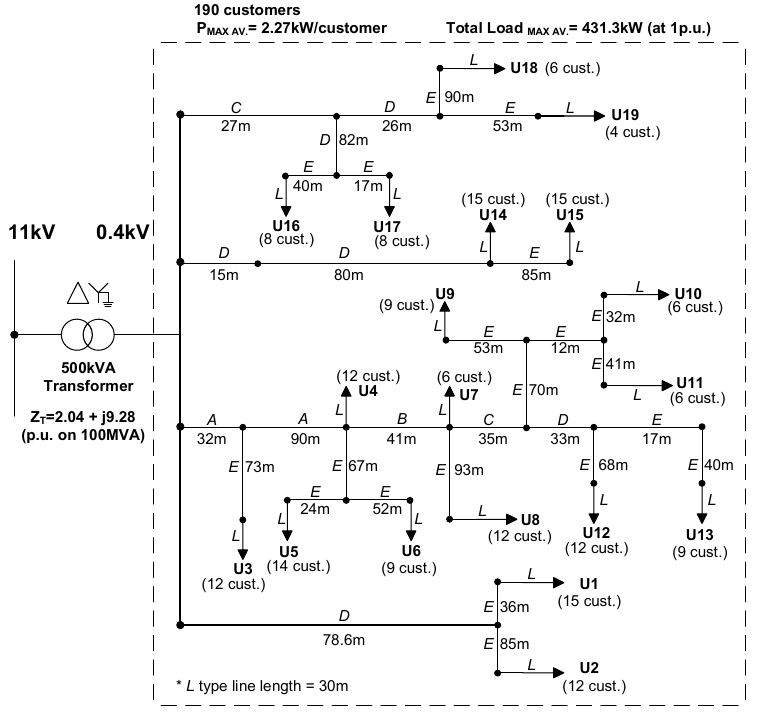
Figure 2. Urban generic LV distribution network model.